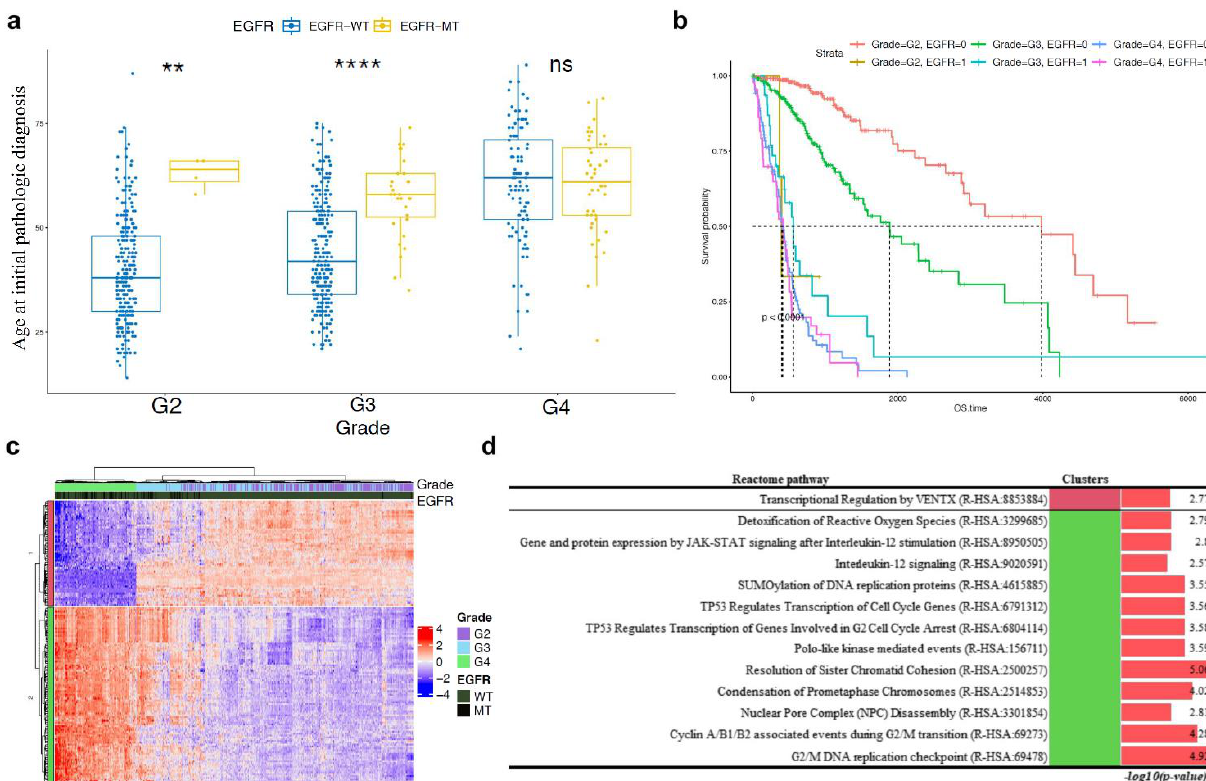
Figure 7. Comparison of ages at initial pathological diagnosis of tumours with EGFR wild-type and those with EGFR . p -values <0.0001 are shown as ****. p -values <0.01 are shown as **. ns is not significant ( a ). Survival analysis comparing EGFR mutant or wild-type and each grade with overall survival. 0 indicates wild-type; 1 indicates mutation. The unit of overall survival time is day ( b ). Heatmap with hierarchical tree of patients based on gene expression pattern with IG over 0.35. Top annotations show tumour grade and genotype (mutant or wild-type) of EGFR . WT indicates wild-type; MT indicates mutation ( c ). Statistically significant results of pathway enrichment analysis of gene clusters in the EGFR hierarchical group ( d ).